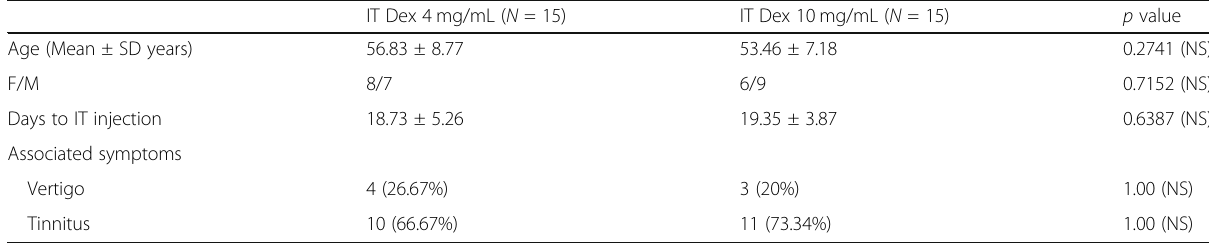
Table 1 Distribution of patients according to age, gender, associated symptoms and onset of IT injection